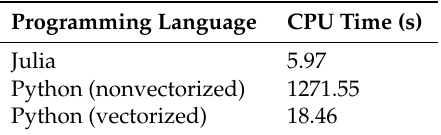
Table 3. Comparison of CPU time for Julia and Python version of Navier-Stokes solver for grid resolution N x = 128 and N y = 128. We note that the codes are written mostly for the pedagogical purpose and the CPU time may not be the optimal time that can be achieved for each of the programming